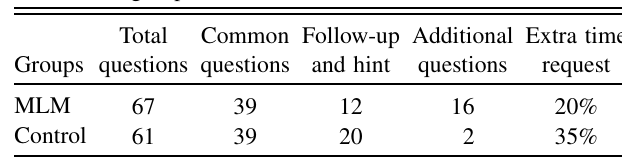
TABLE III. Comparison of clicker questions used for MLM and control